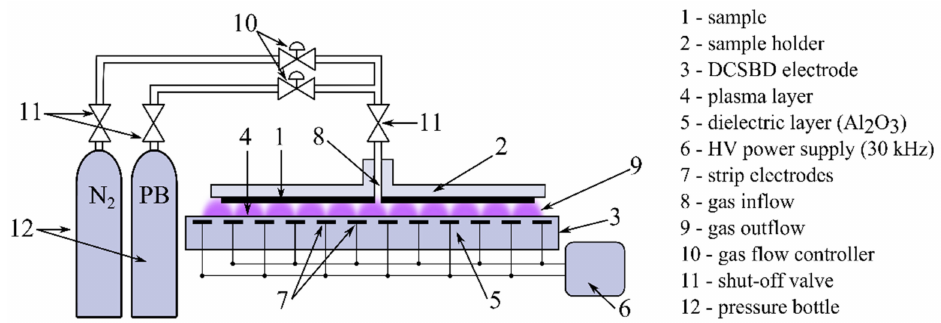
Figure 1. Schematic representation of the experimental